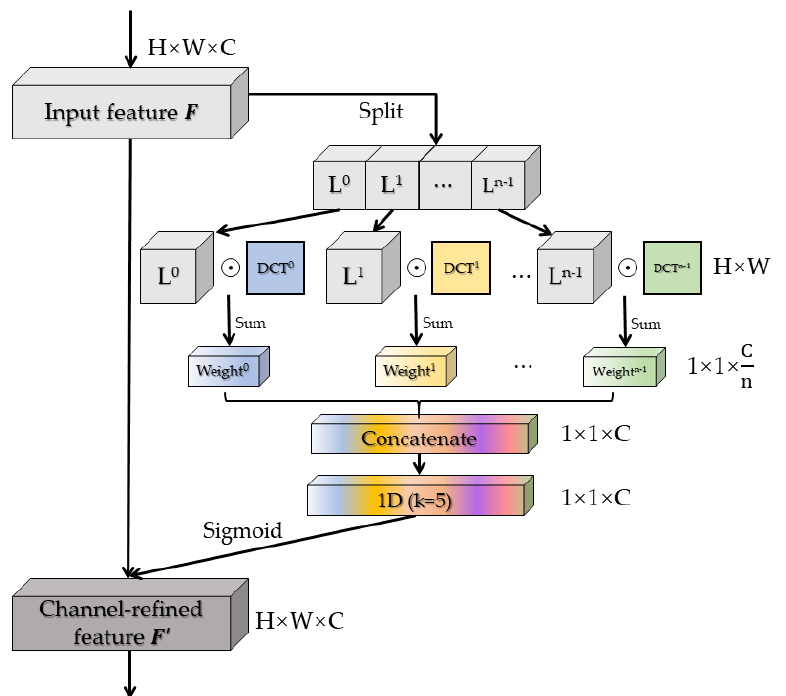
Figure 9. Improved channel attention